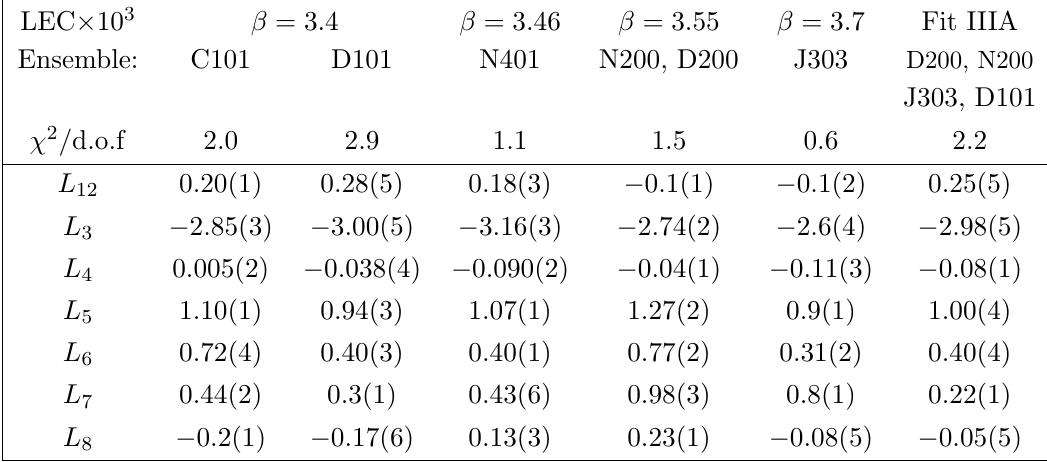
Table 6 . Values of the LECs obtained in the (cid:12)ts Tr M = C with the scale setting A . LEC (cid:2) 10 3